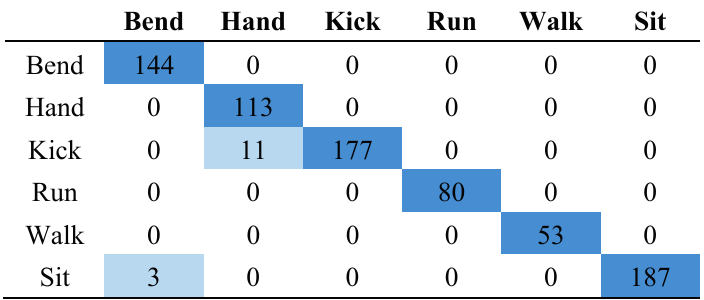
Table 3. Confusion matrix for recognition results of all